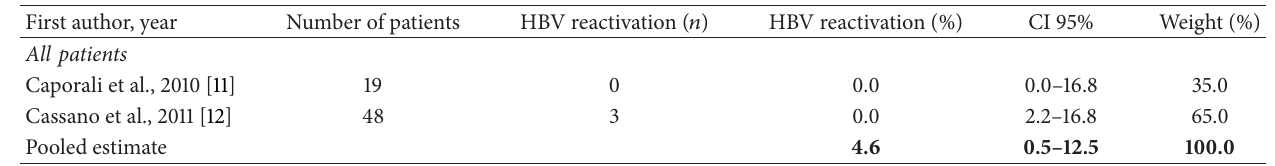
Table 5: Meta-analysis on HBV reactivation among patients treated with adalimumab.